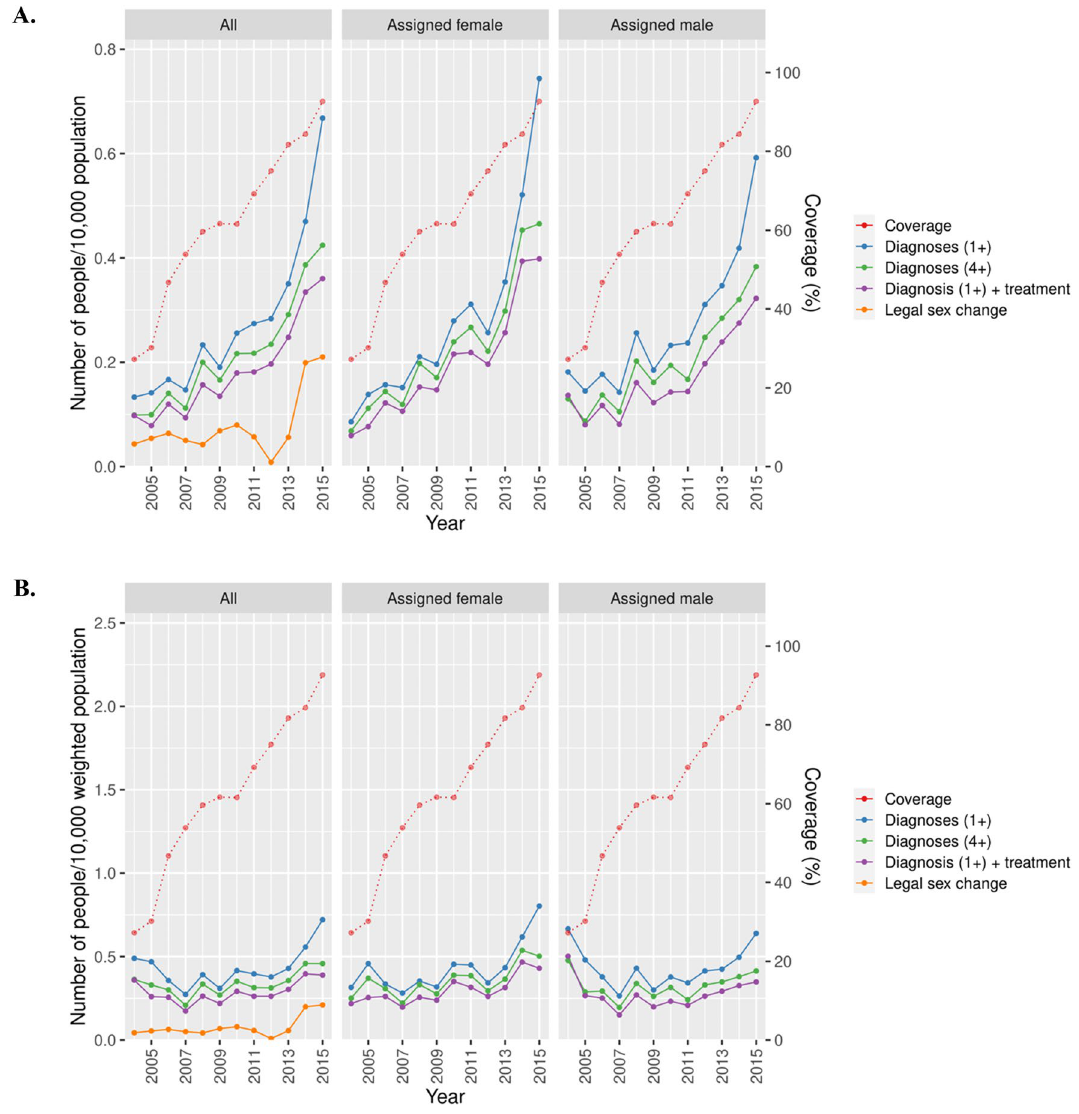
Figure 2. Crude ( A ) and coverage-adjusted ( B ) incidence rates of GD in Sweden 2004–2015 defined by ≥ 1 diagnosis, ≥ 4 diagnoses, ≥ 1 diagnosis with GCMI, stratified by birth assigned sex, along with legal sex rates and coverage in the